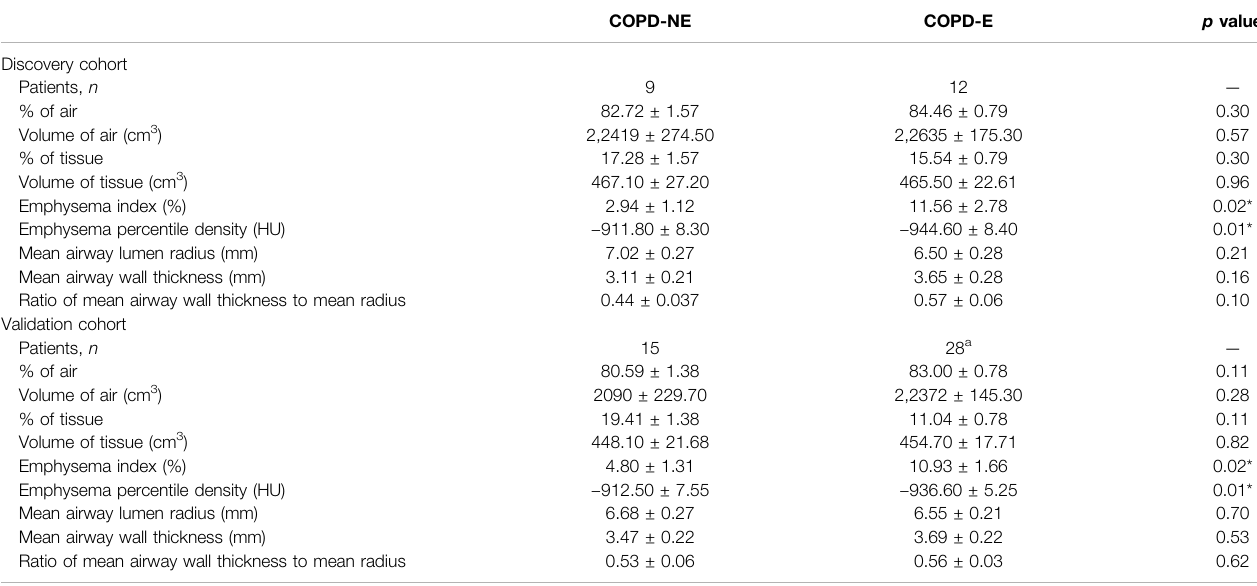
Data represent the mean ± SEM of radiological parameters for all patients in each group. a Raw radiological data were not available for one patient in the COPD-E group of the validation cohort. COPD, chronic obstructive pulmonary disease. * p <